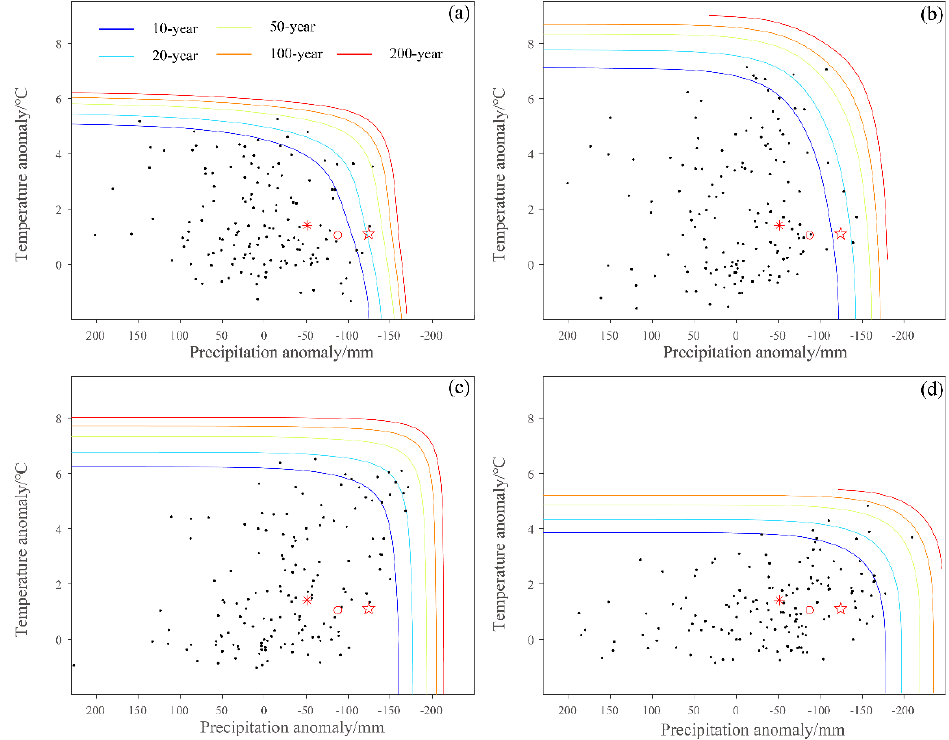
Figure 9. Return period of concurrent events under RCP8.5 scenario for October-March of 1950–2099 in the study region (( a ) GFDL-ESM2M; ( b ) HadGEM2-ES; ( c ) IPSL-CM5A-LR; ( d ) NorESM1-M).